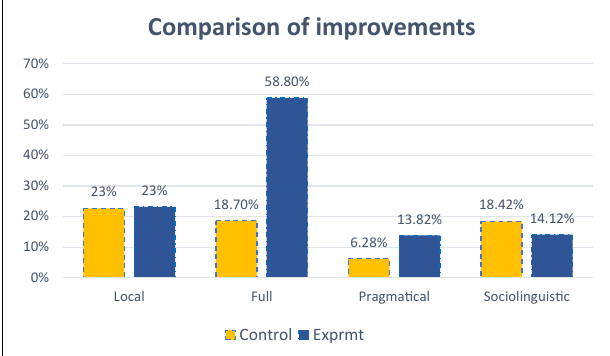
FIGURE 5 | A comparison of improvements regarding the four categories of language